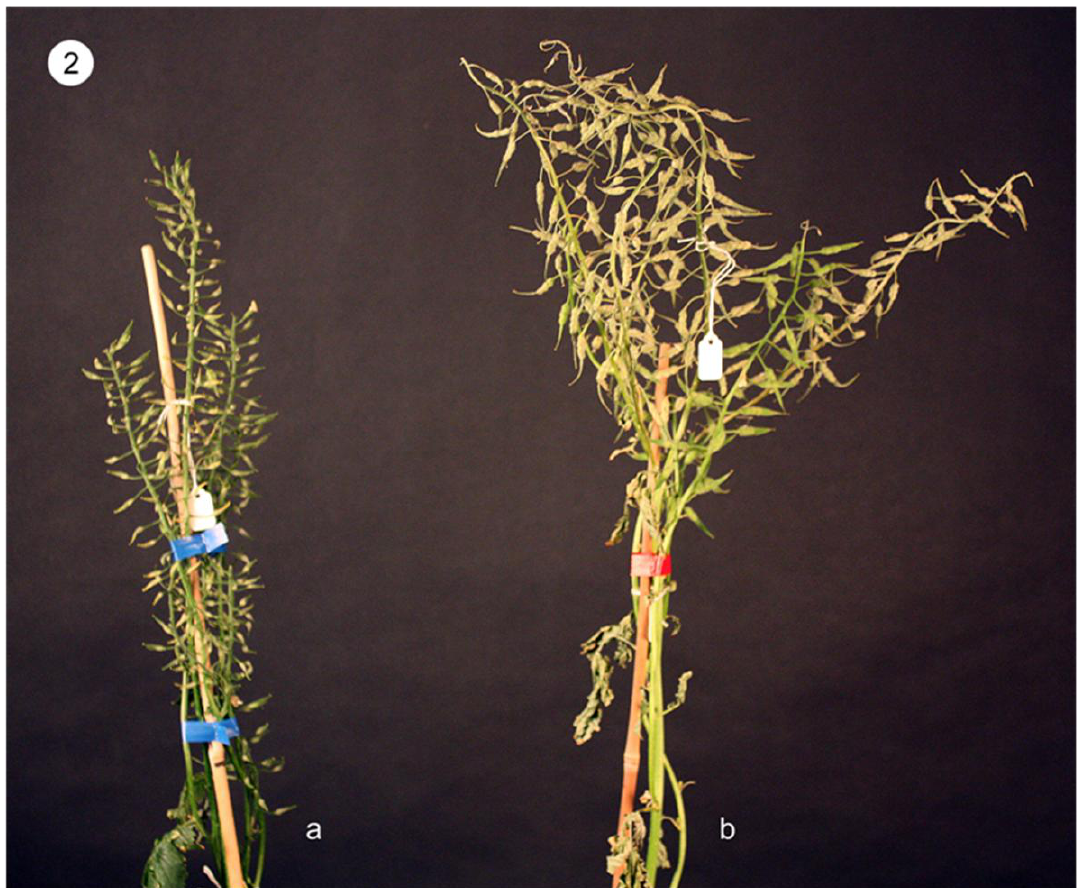
Figure 2. Seed setting of self-incompatible and self-compatible S1 plants. ( a ) Self-incompatible S1 plant; ( b ) Self-compatible S1